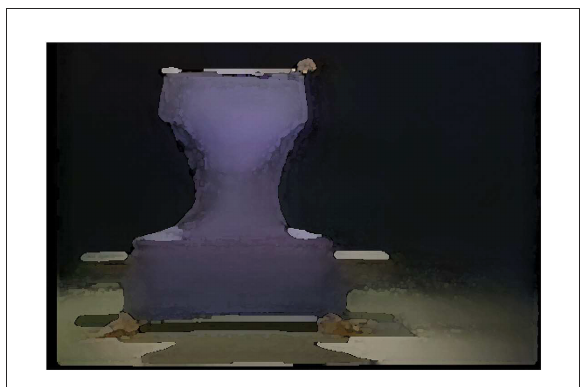
FIGURE5 The media frame of the arrival point of move 47.